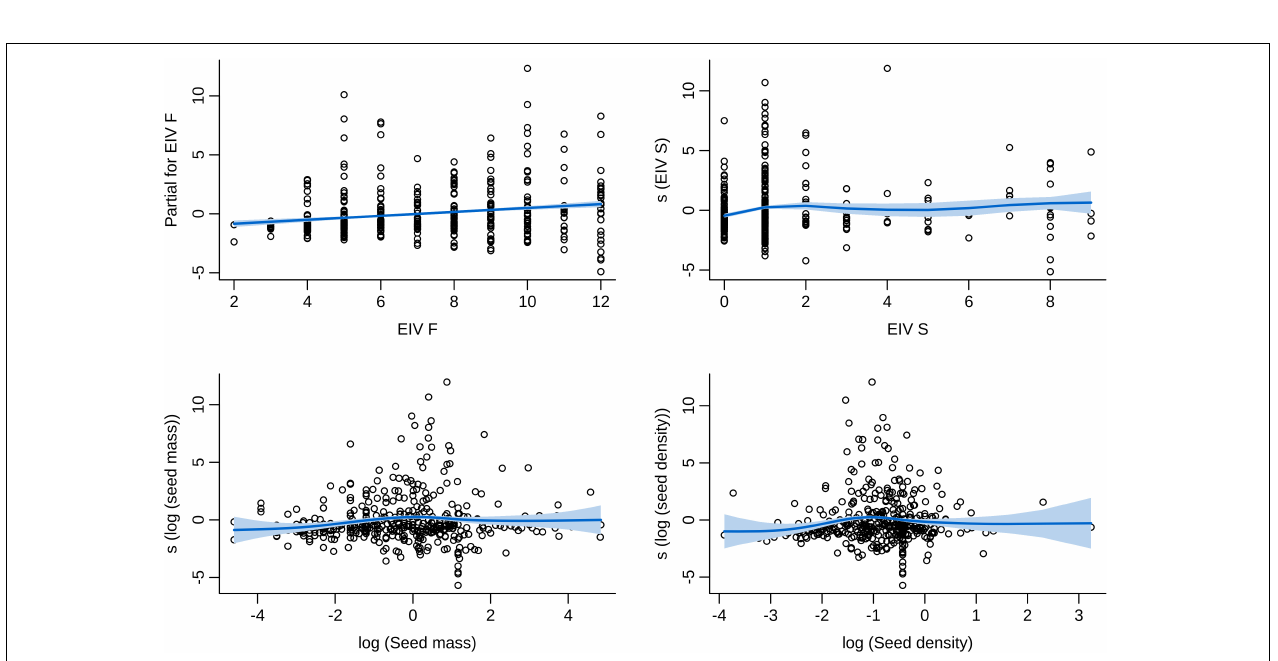
FIGURE 4 | Relationship between plant/seed traits and the number of avian vector species. Log seed mass and log seed density presented unimodal relationships with the number of vector species. The soil moisture EIV was positively and linearly related with the number of vector species, and the salinity EIV had a non-linear relationship with the number of vector species. Fitted lines and their standardized error bands represent the final zero-truncated GAM models. The Y Axis represents centered partial residuals from the model fit (the “s” term represents smoothing terms of the variables modeled as non-linear). EIV, Ellenberg Indicator Value for soil moisture (F) and salinity (S). Seed mass and seed density are weakly correlated (Spearman’s ρ = 0.18, p < 0.001).